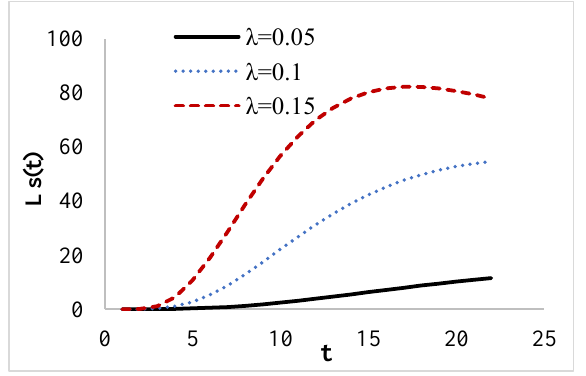
Figure 3. Effect of 